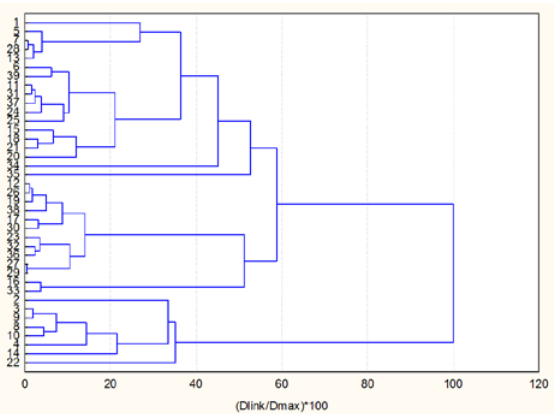
Figure 4. Hierarchical dendrogram for grouping of 39 patients.